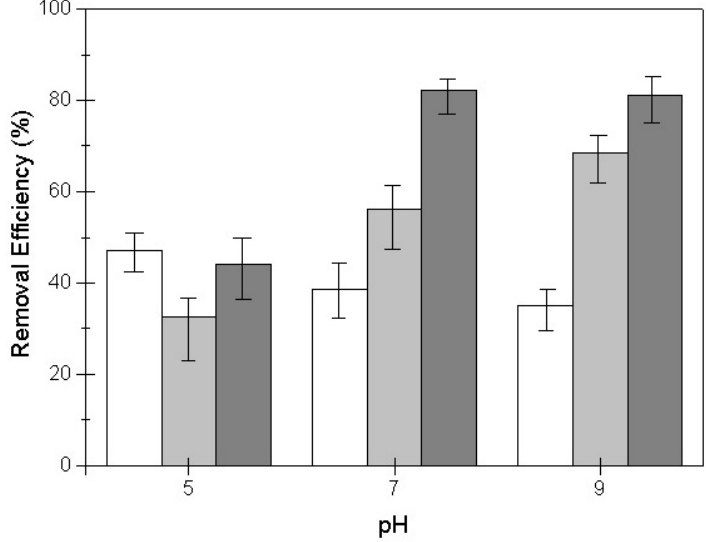
Figure 5. Removal efficiency of COD present in cold meat industry wastewater employing 298 K and di ff erent initial pH values. The current densities were 2 mA cm − 2 ( (cid:3) ), 4 mA cm − 2 ( (cid:4) ), and 6 mA cm − 2 ( ■ ).